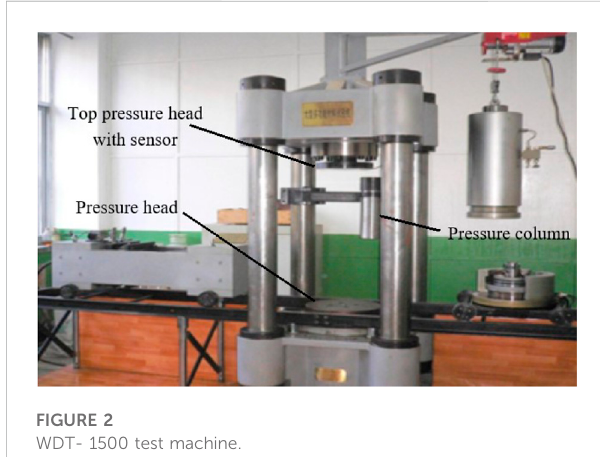
FIGURE 2 WDT- 1500 test